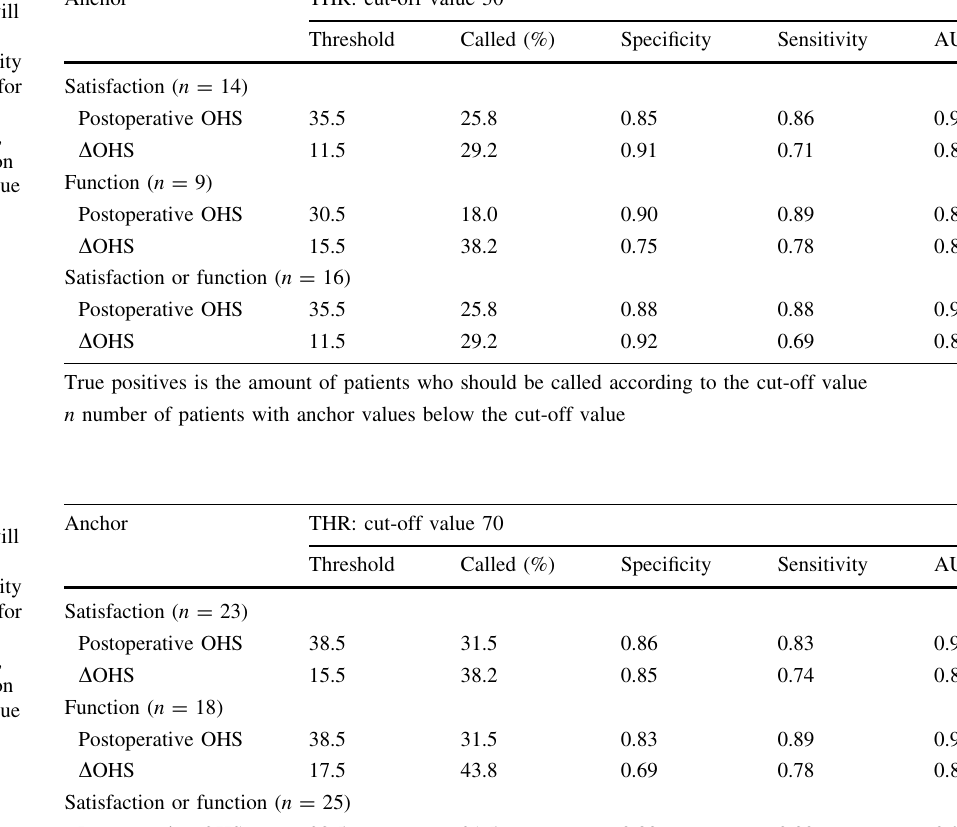
Table 2 Thresholds, percentage of patients who will be called with the given threshold, specificity, sensitivity and area under curve (AUC) for OHS and D OHS anchored to patient-perceived satisfaction, function and either satisfaction or function with a cut-off value of 50